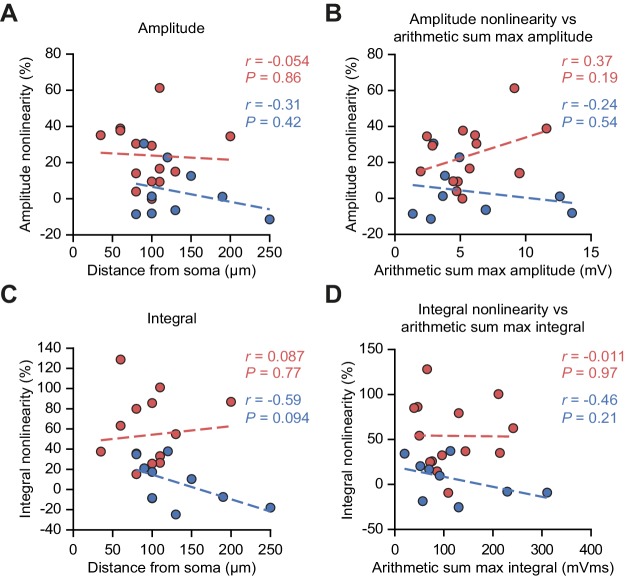
uEPSP nonlinearity does not depend on uncaging location distance from soma or on the size of the arithmetic sum of uEPSPs.(A) uEPSP amplitude nonlinearity plotted against glutamate uncaging site distance from soma. (B) uEPSP amplitude nonlinearity plotted against maximal arithmetic sum of uEPSP amplitudes. (C) As (A) but for time-integrals. (D) As (B) but for time-integrals. Statistics: r = Pearson correlation coefficient, p=associated two-tailed significance.